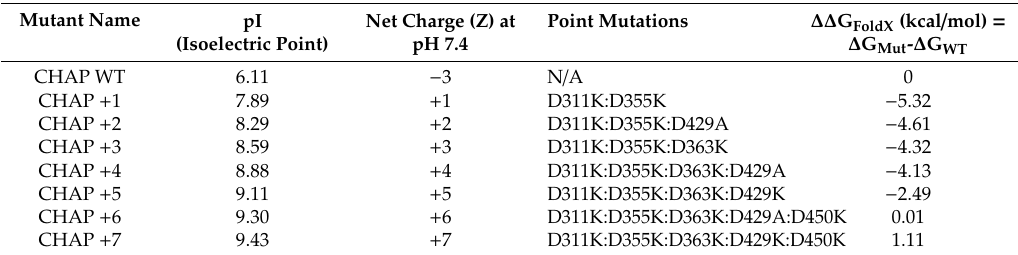
Table 1. PlyCA CHAP Selected Mutations.